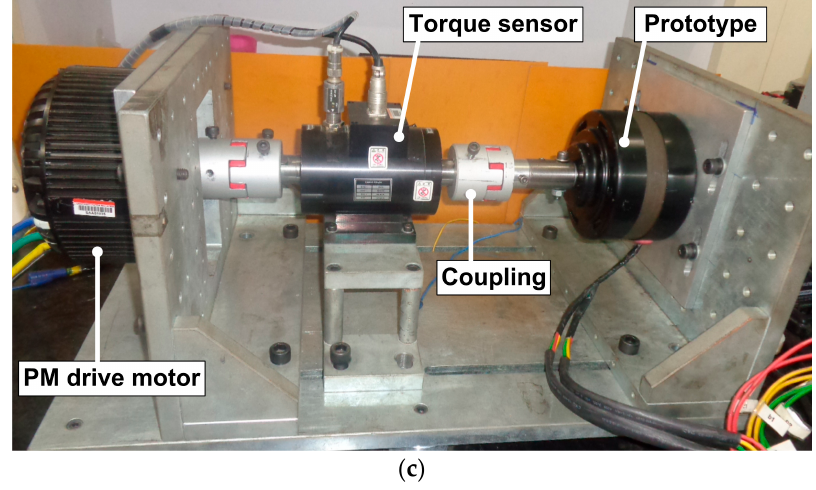
Figure 10. Experimental setup and test rig: ( a ) DC power measurement configuration; ( b ) AC power measurement configuration; ( c ) Prototype in test rig.